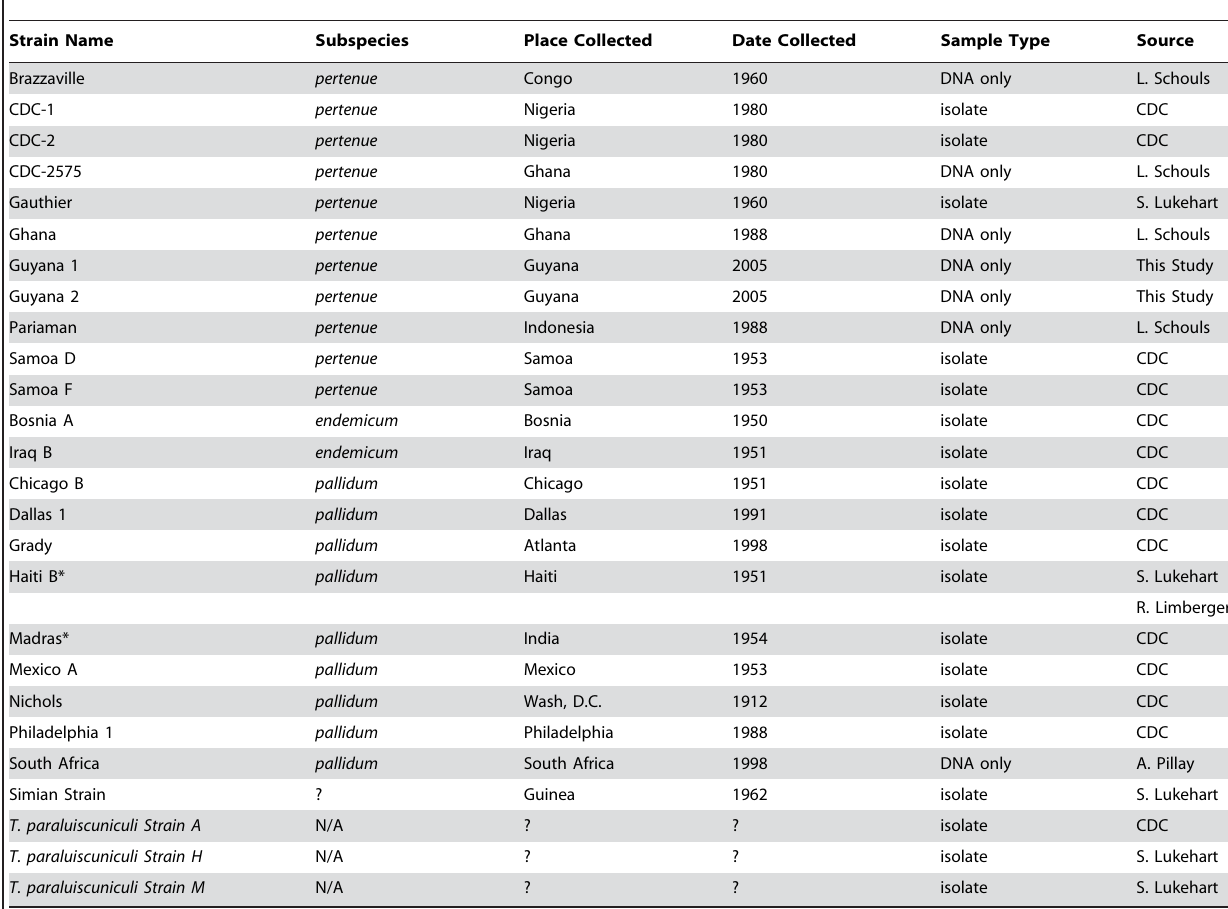
Table 1. Treponema sp. analyzed in this study